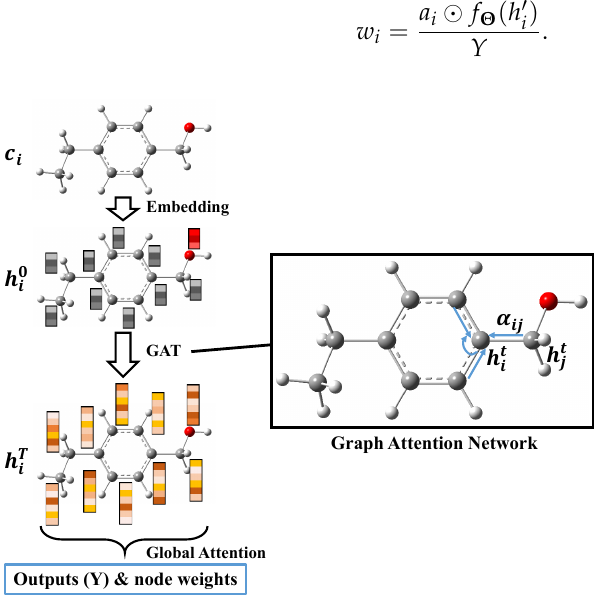
Figure 2. The architecture of the attention-based graph neural